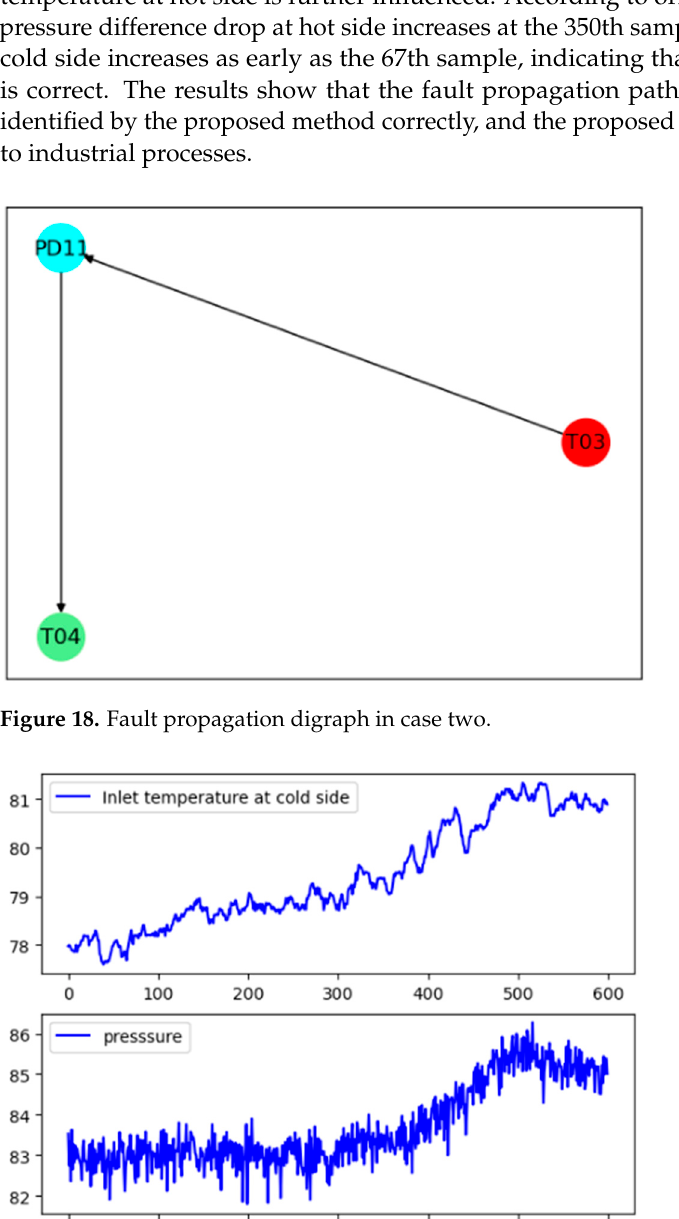
Figure 17. Original data in case one.